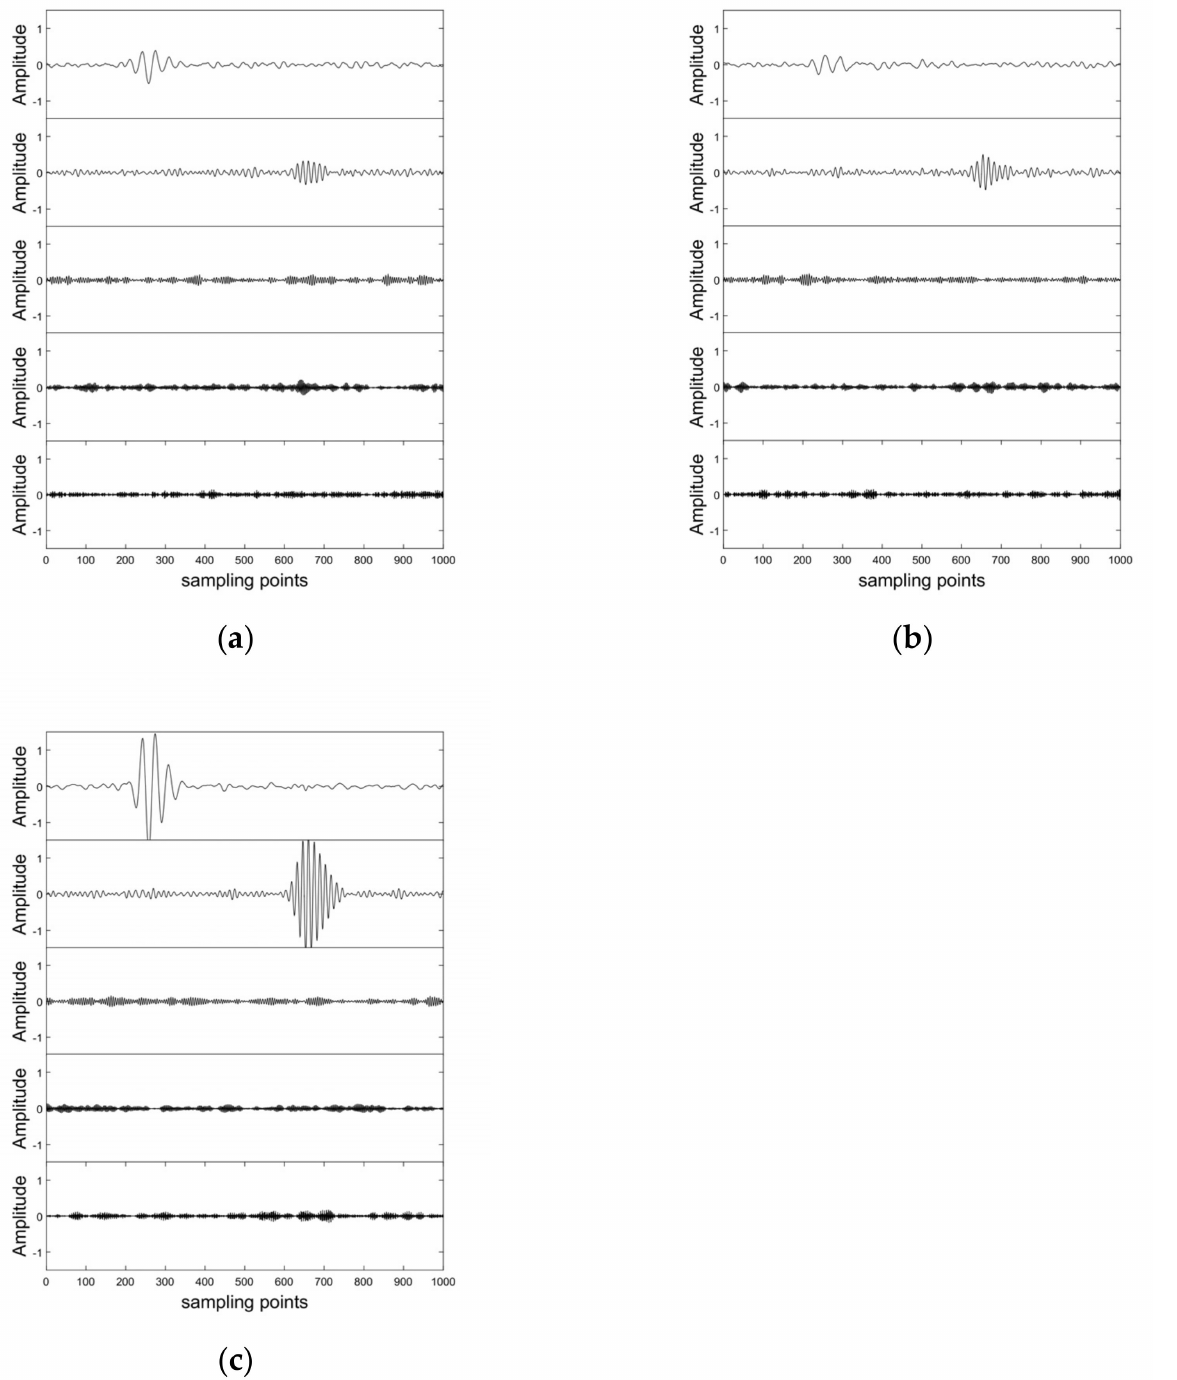
Figure 5. The IMFs of re-constrain VMD for the synthetic three-component data. ( a ) The re-constrain VMD result of the H1 component. ( b ) The re-constrain VMD result of the H2 component. ( c ) The re-constrain VMD result of the vertical